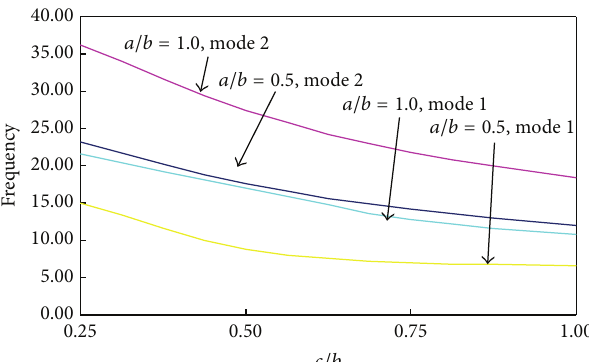
Figure 11: Value of frequency parameter for orthotropic trapezoidal plates for different values of 𝑐/𝑏 and fixed values for 𝛼 = 0.2 , 𝛽 = 0.4